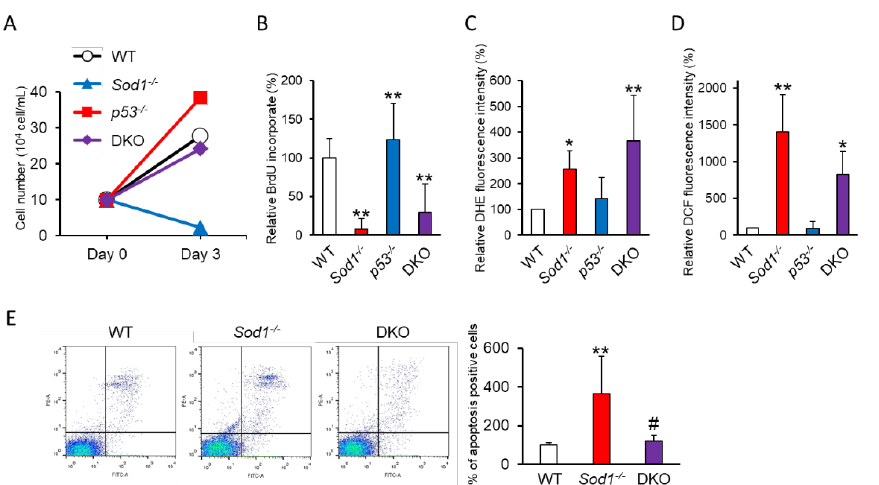
Figure 1. p53 insufficiency suppressed cytoplasmic superoxide dismutase (SOD1) loss-mediated apoptotic cell death. ( A ) The cell numbers of wild-type (WT); Sod1 − / − , p53 − / − ; and double-knockout (DKO) fibroblasts were counted at the times indicated. ( B ) The cell viabilities of each type of fibroblast were measured based on the incorporation of bromodeoxyuridine (BrdU) into the fibroblasts. ( C , D ) The intracellular superoxide accumulation was measured by flow cytometry with dihydroethidium (DHE) ( C ) and CM-H 2 DCFDA (DCF) ( D ) in each type of fibroblast. ( E ) Apoptosis in fibroblasts was analyzed by flow cytometry with propidium iodide (PI) and annexin V. Statistical analyses were performed using a two-way analysis of variance. The error bars indicate the standard deviation of three independent experiments (n = 3). * p < 0.05, and ** p < 0.01 vs. WT. # p < 0.05 vs. Sod1 − / − .